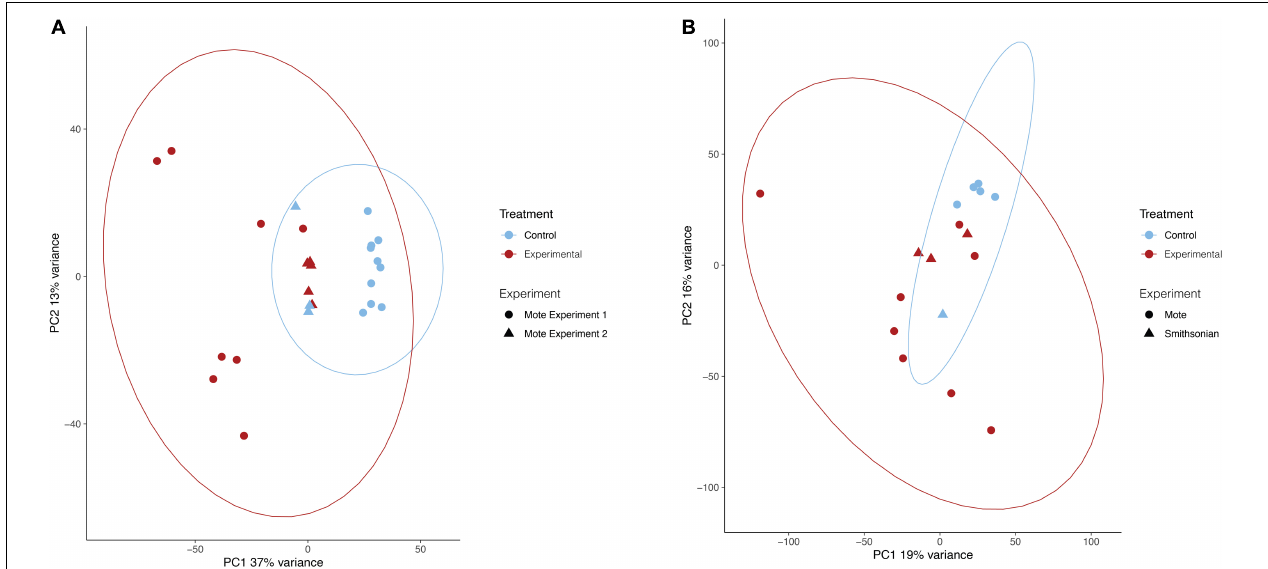
FIGURE 2 | Principal component analysis of treatments for O. faveolata and M. cavernosa . (A,B) Red represents experimental, blue indicates control. Shape indicates experiment, as three separate transmission experiments were run at Mote Marine Laboratory (experiment 1 and 2) and the Smithsonian Marine Station. Counts normalized using variance stabilizing transformation (VST) from DESeq2 (Love et al., 2014). Ellipses of normalized data assumed a multivariate normal distribution. (A) O. faveolata experimental and control samples group based on treatment. 37% of the variance is explained by the differences between treatment (control vs. disease) on the PC1 axis, whereas 13% of the variance is found on the PC2 axis. After pre-filtering, O. faveolata had 18,066 genes for 26 individual samples. (B) M. cavernosa experimental and control samples grouped based on treatment. Overall, 19% of the variance on PC1 was explained by the treatment for M. cavernosa , whereas 16% of the variance is found on the PC2 axis. After pre-filtering, M. cavernosa had 13,816 genes for 17 individuals.